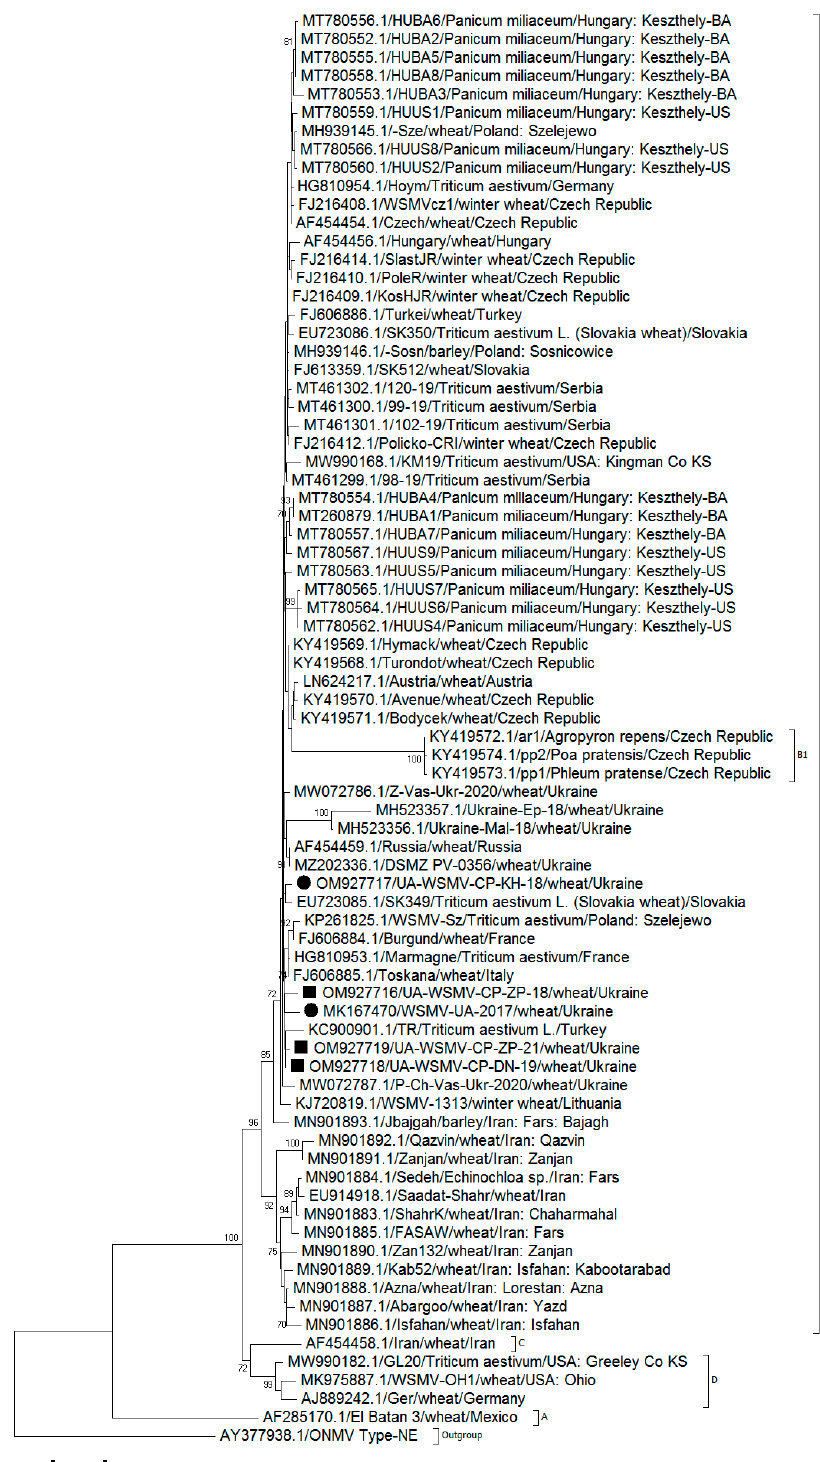
Figure 5. Neighbor-Joining (NJ) tree showing phylogenetic relationships between the isolates of wheat streak mosaic virus (WSMV). The coat protein gene region was used to construct the tree. Ukrainian isolates studied in this work are shown with dots (monoinfection of WSMV) and squares (mixed infection with HPWMoV). Bootstrap values <70 are not shown for respective branches. Oat necrotic mottle virus (ONMV) sequence (AY377938.1) was used as outgroup. Scale bar indicates 0.05 base substitutions/site.